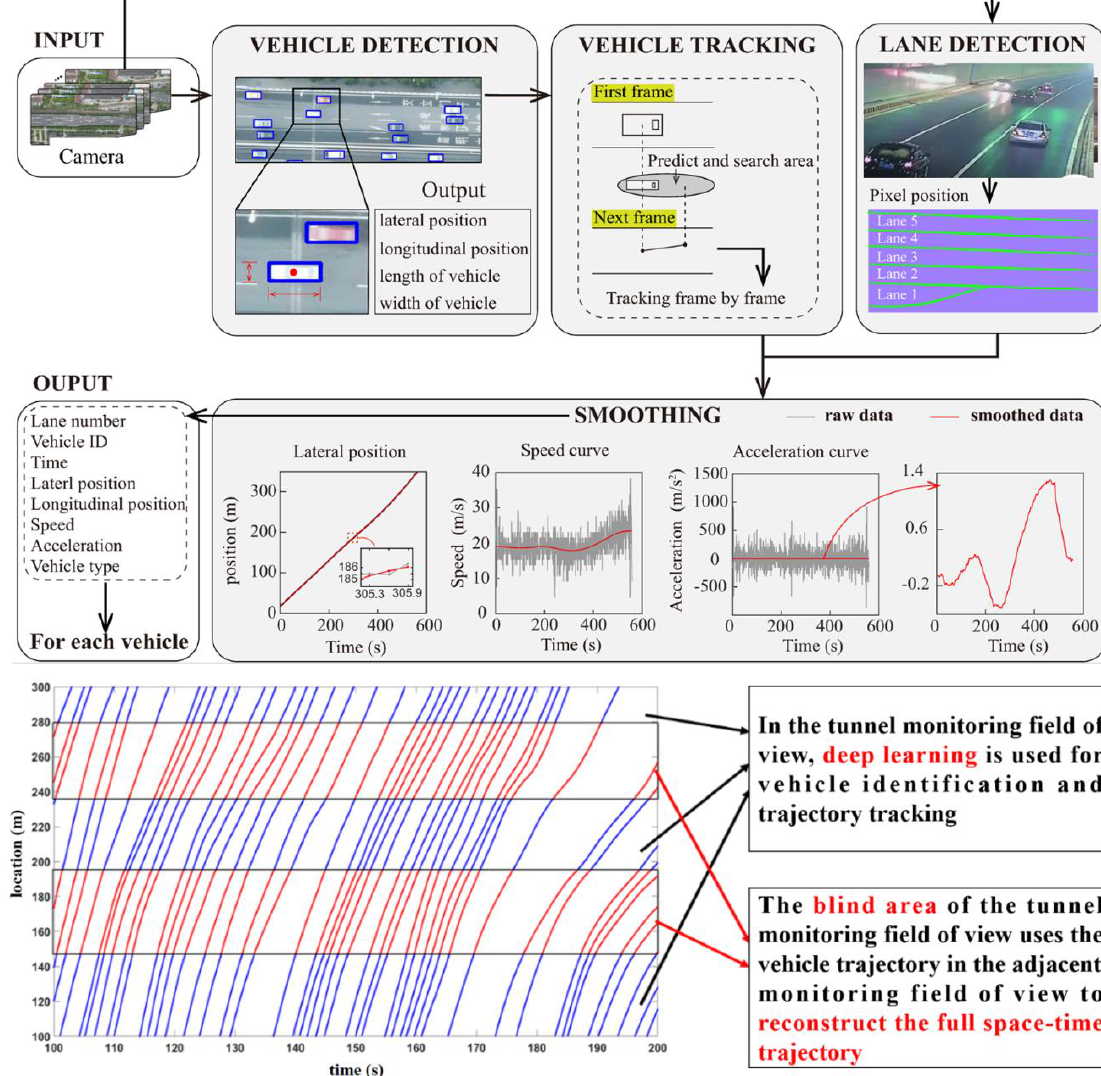
Figure 1. Schematic diagram of extraction steps of space – time trajectory.